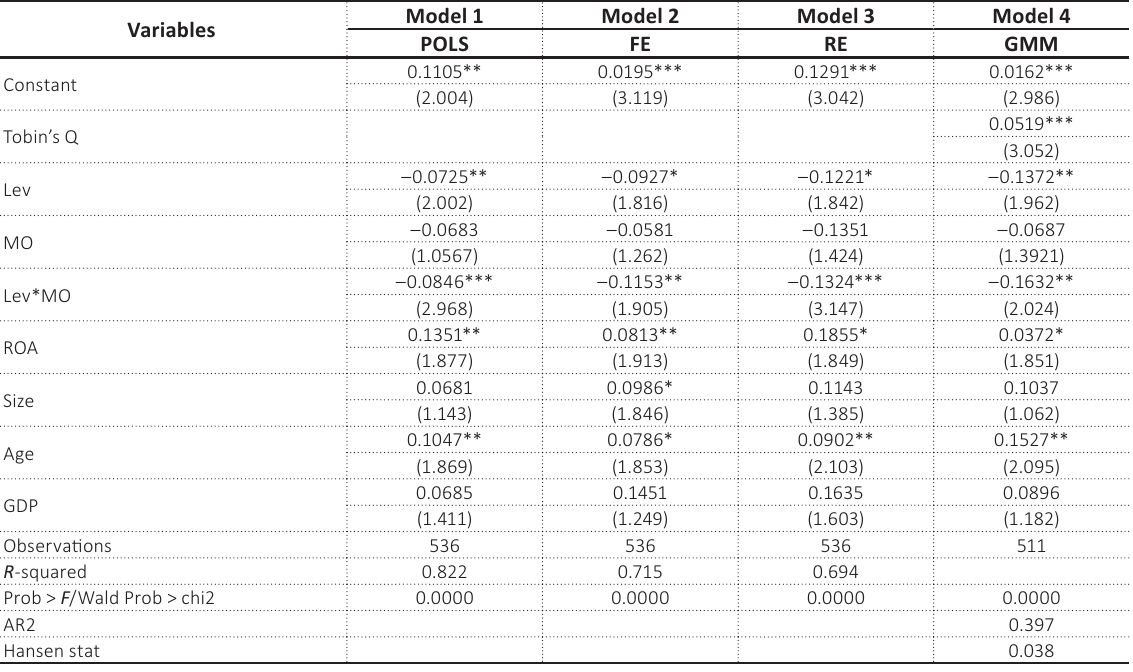
Table 4. Regression model